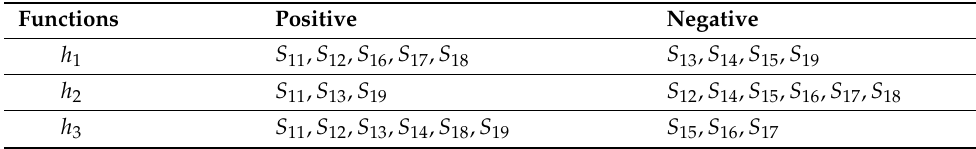
Table 7. Signs of functions h 1 , h 2 and h 3 in the subregions of S 1 . Functions